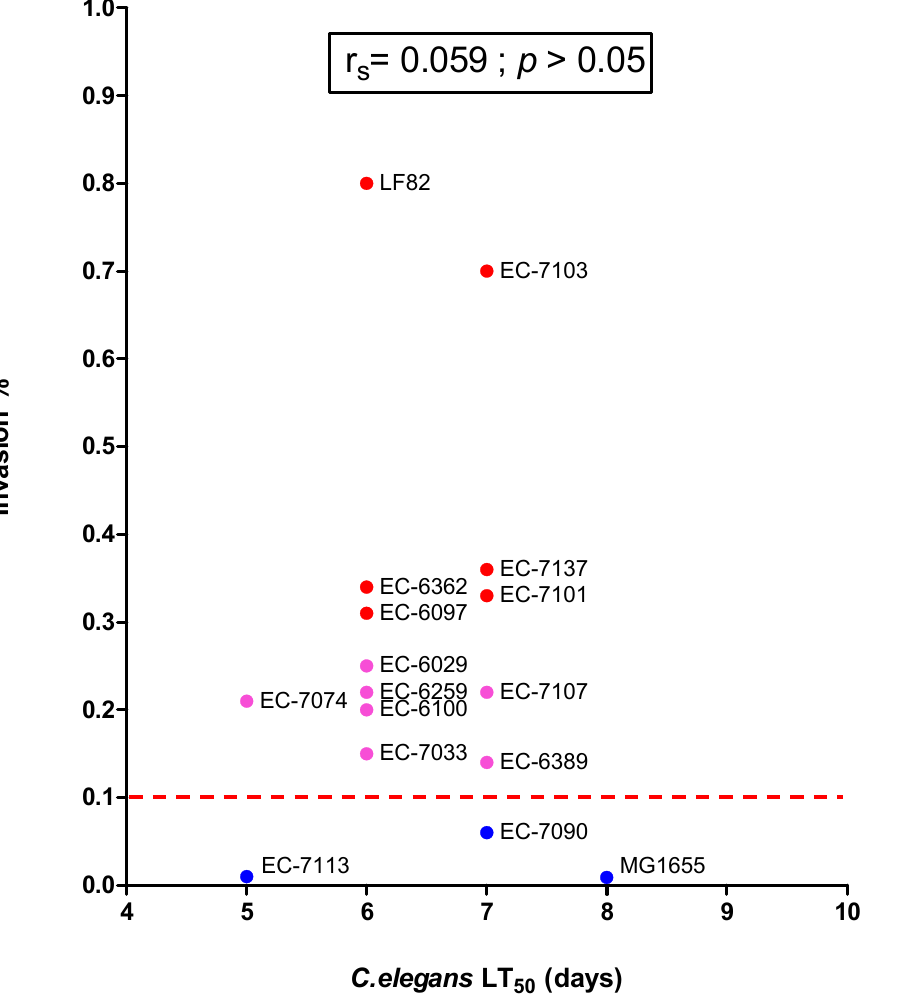
Figure 8. Lack of association between the median lifespan (LT 50 ) of E. coli -infected C. elegans and the corresponding invasion ratio with the I-407 epithelial cell line, for 16 distinct E. coli strains. Strains with an invasion index ≥ 0.1% (the threshold indicated by a dotted line) are classified as AIEC. The correlation’s statistical significance was assessed by calculating Pearson’s regression coefficient and Spearman’s non-parametric rank correlation r s coefficient.